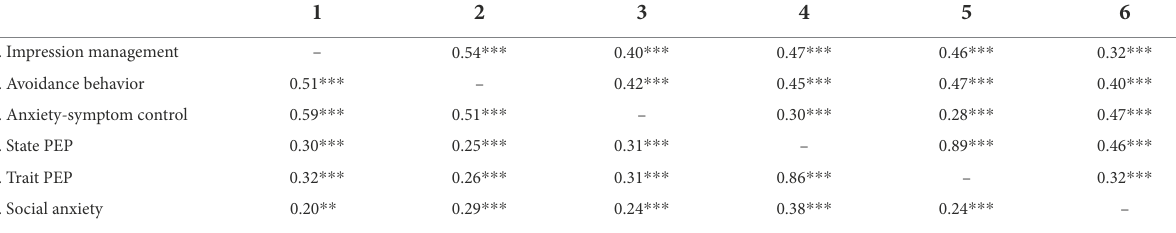
TABLE 3 Correlations between the variables.